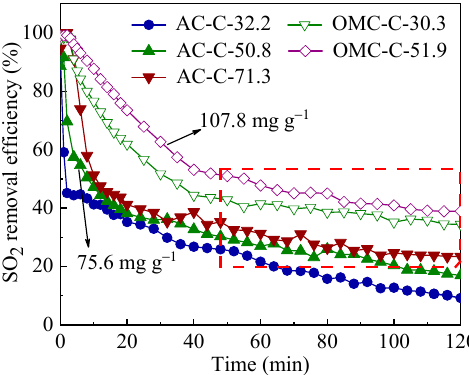
Figure 5. SO 2 removal efficiency versus time for AC and OMC samples. Reaction conditions: 2.5 g of adsorbents, 1500 ppm SO 2 , 5% O 2 , 10% H 2 O, N 2 balance, flow rate 1.2 L · min − 1 , at 353 K.